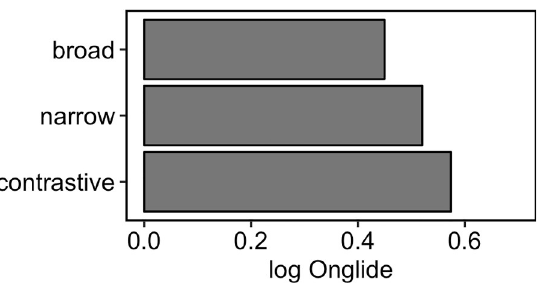
Fig 16. Medians of the rising simulated onglide distributions for the three focus types.